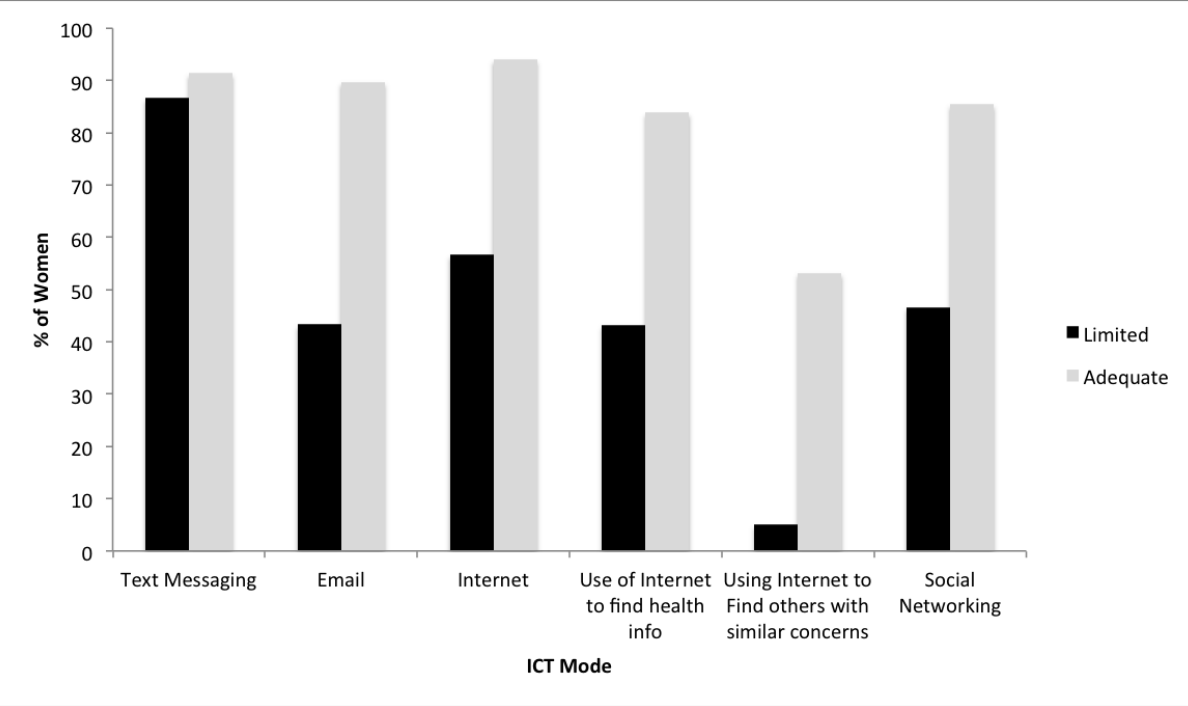
Figure 1. Rates of use of information and communication technology modality and function by English language proficiency (adequate vs